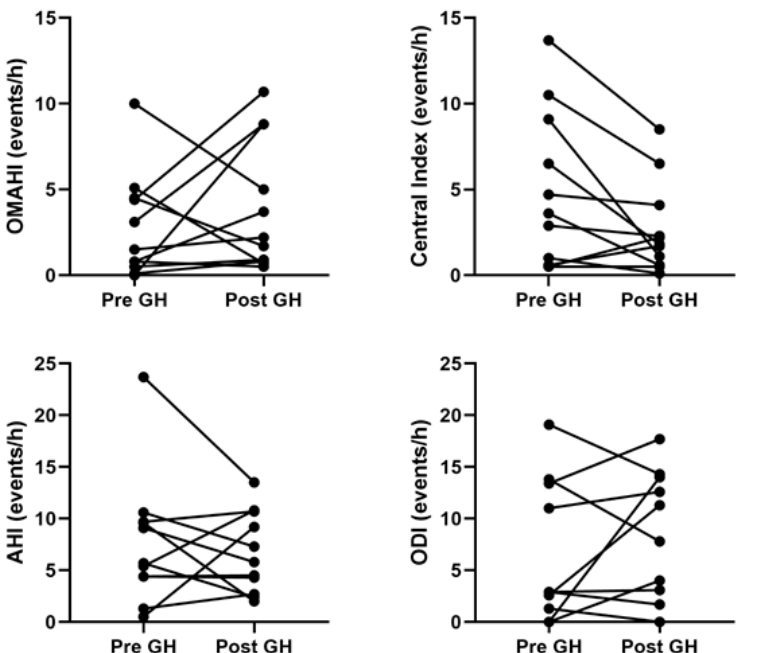
Figure 1. Analysis of summary polysomnography variables before and after starting recombinant human growth hormone showed no differences. AHI, apnea-hypopnea index; ODI, oxygen desaturation index; OMAHI, obstructive-mixed apnea hypopnea index. Table 4. Comparison of polysomnography results before and after initiation of recombinant human growth hormone.